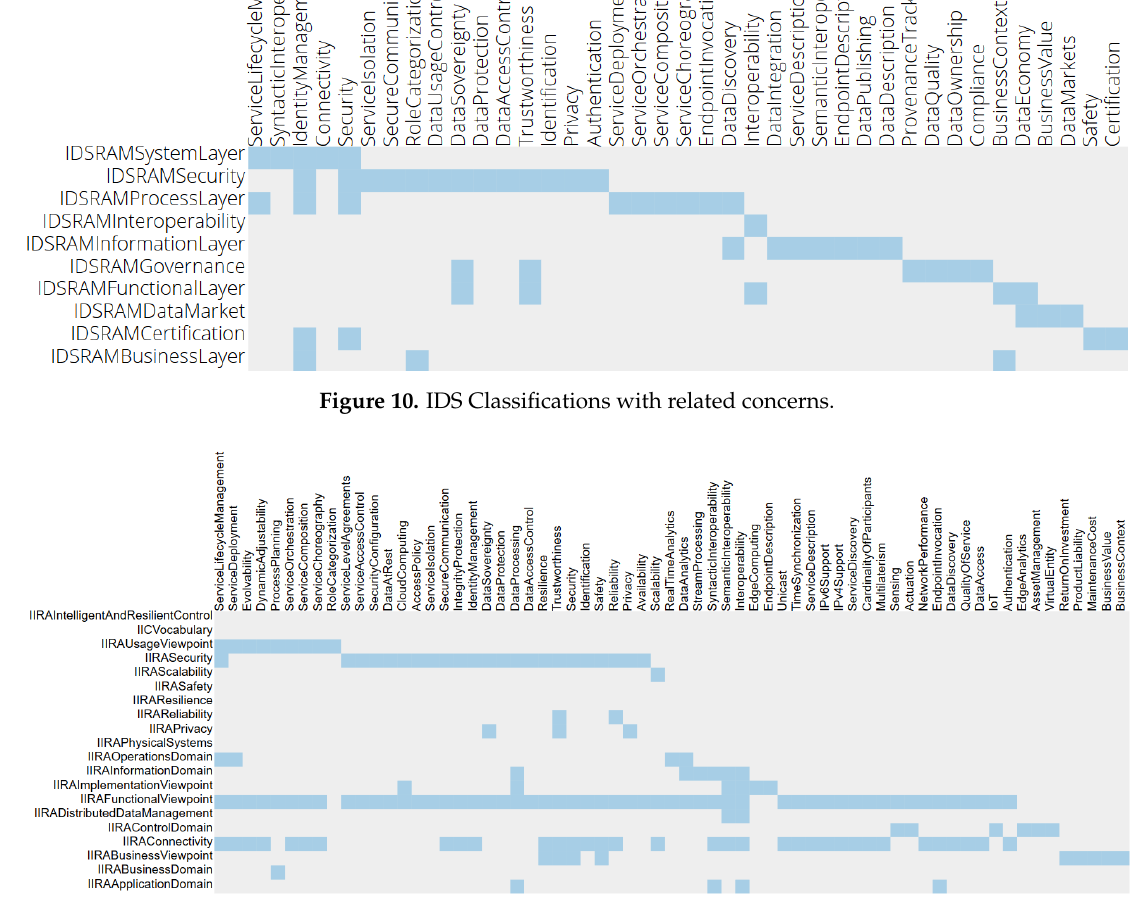
Figure 11. Concerns as referenced by the Industrial Internet Reference Architecture